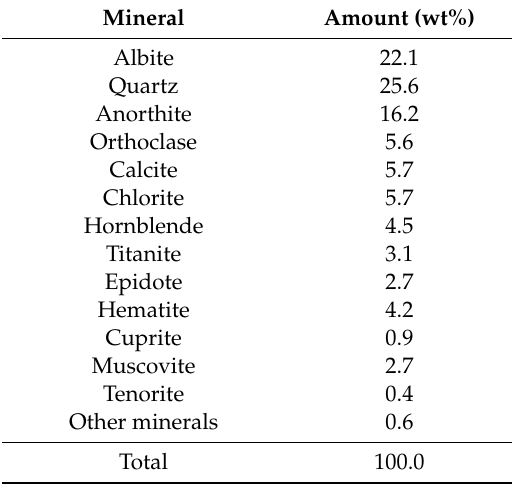
Table 3. Mineralogical composition of copper ore.